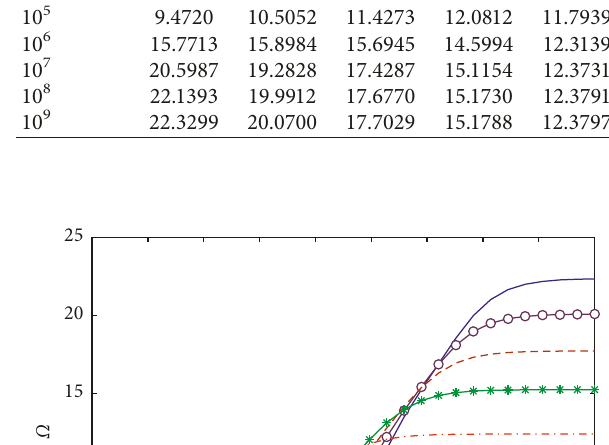
Table 6: Nondimensional fundamental frequencies for the non- uniform double-beam system under elastic boundary with r s / m 2 and k c c (cid:31) 100 N (cid:31)